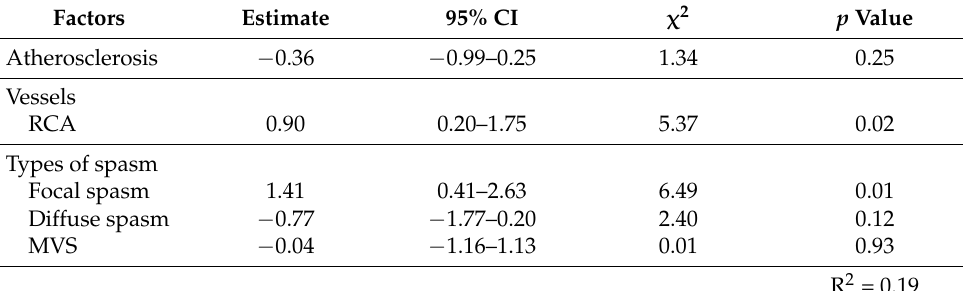
Table 3. Logistic regression analyses of lesion characteristics of the presence of